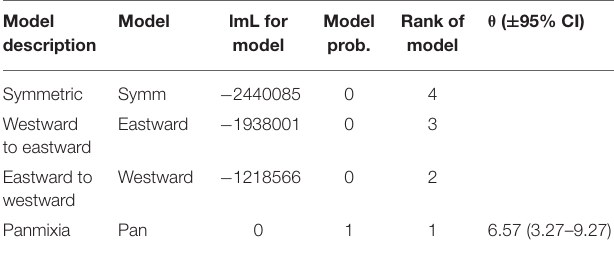
TABLE 3 | Comparison of Bezier log marginal likelihood (lmL) differences, model probabilities, and rank for four different gene flow models (Symm, symmetric horizontal migration; Eastward, migration from westward to eastward banks; Westward, migration from eastward to westward banks; Pan, panmixia) within the NW